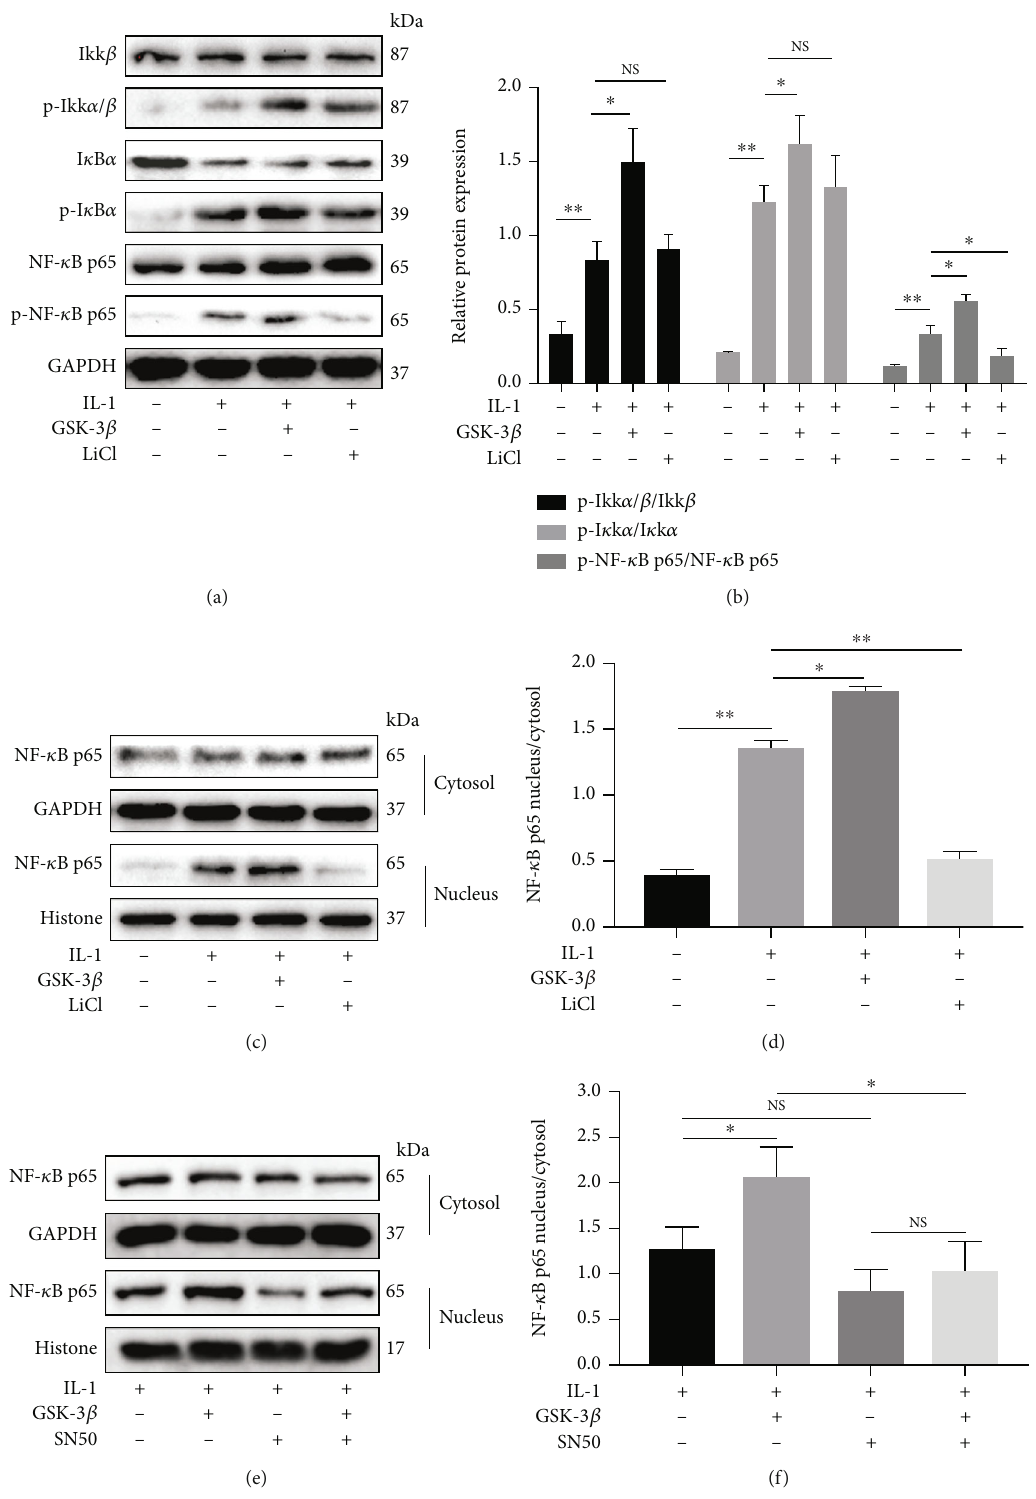
Figure 4: GSK-3 β regulates the NF- κ B signaling pathway in IL-1 β -induced in fl ammation. Phosphorylation and/or total expression of IKK β , IKK α / β , I κ B α , and NF- κ B p65 (a) and (b) were detected by western blotting. Visualization and quanti fi cation of the expression of cytoplasmic (c) and (d) and nuclear (e) and (f) NF- κ B p65. All results are expressed as the mean ± SD ( n = 3 ). NS: not signi fi cant, ∗ P < 0 : 05 , and ∗∗ P < 0 : 01